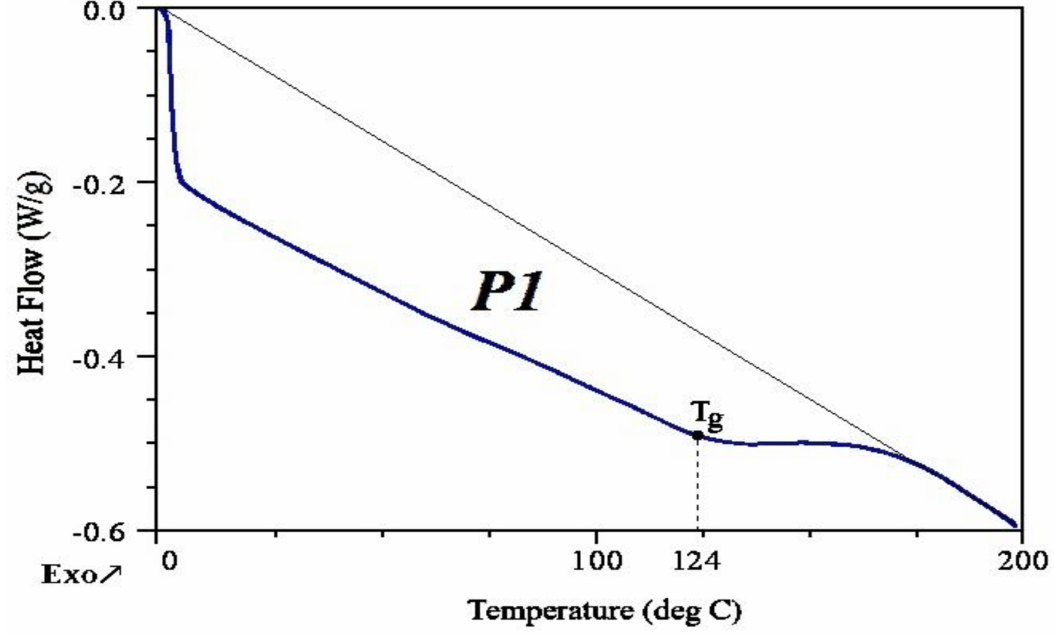
Figure 6. DSC curve of PLA-polyol.